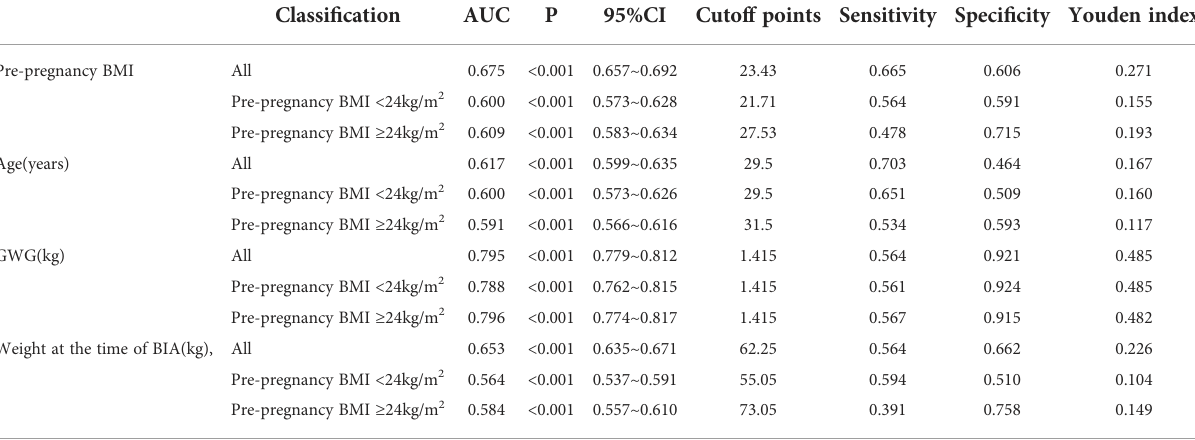
TABLE 5 Analysis of the predictive effect of general indicators under pre-pregnancy BMI on